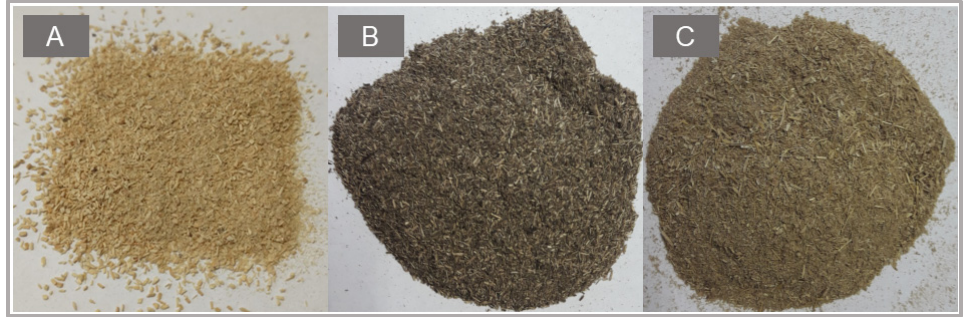
Figure 1. Ground and sieved residues ( A ) pine sawdust, ( B ) sunflower seed hulls and ( C ) corn residues mix.